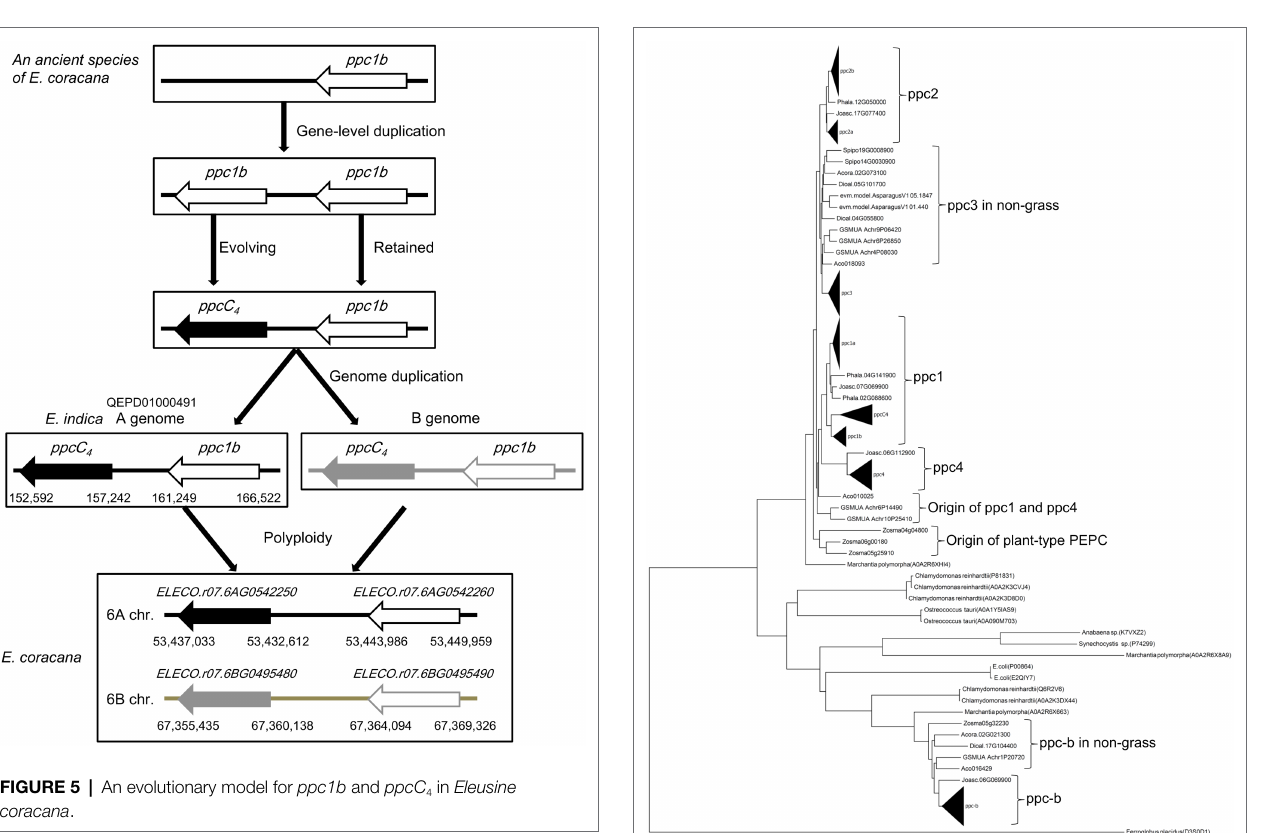
ppc2b and ppc4. Regarding ppc1a and ppc2b, 18 fixed